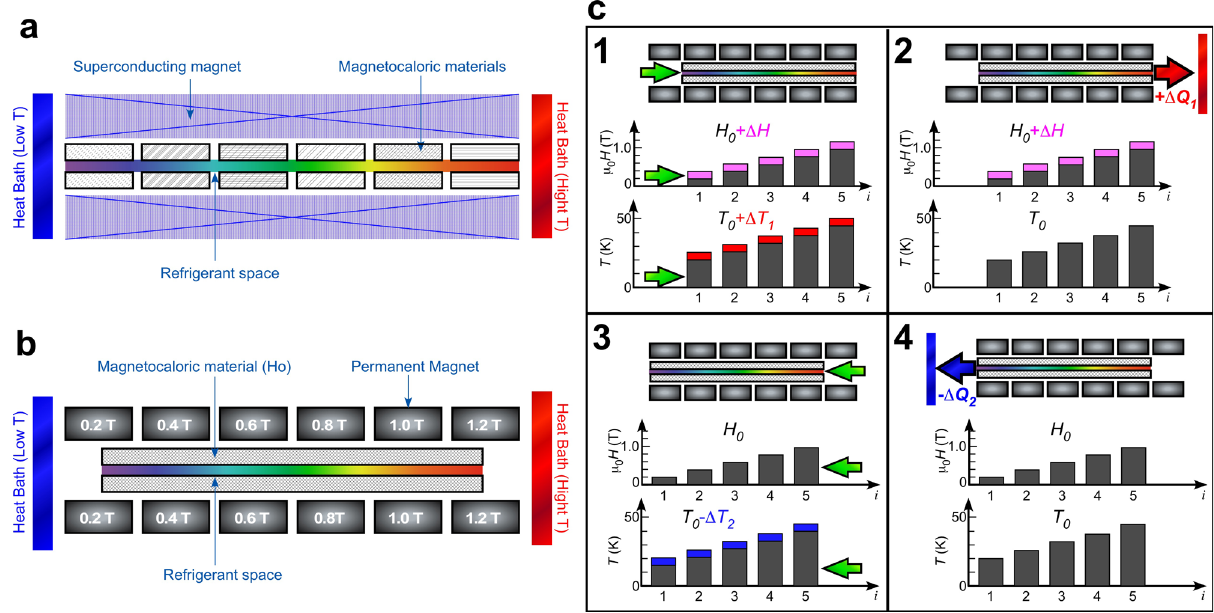
Fig. 6 Schematic illustration of active magnetic regenerator (AMR) using permanent magnets and holmium. a A cross-section of AMR setup 2,24 . The AMR constitutes a superconducting magnet, magnetocaloric materials, refrigerant space, and heat baths (low- and high-temperature sides). The magnetocaloric materials have different phase transition temperatures to obtain a large magnetocaloric effect at each position. b Possible setup of the proposed magnetic refrigeration (MR) system using a small change in magnetic fi eld. The system constitutes pairs of permanent magnets, magnetocaloric material (holmium), refrigerant space, and heat baths. The set of permanent magnets generate a magnetic fi eld gradient from 0.2 to 1.2 T as a bias magnetic fi eld μ 0 H 0 to change the magnetic phase transition temperature of the magnetocaloric material Ho. The magnetic fi eld change Δ μ 0 H is realized by mechanically moving the magnetocaloric material in the horizontal direction in this fi gure. c The MR cycle of the proposed AMR system. The gray color in the magnetic fi eld and temperature graphs denotes the bias fi eld μ 0 H 0 and the original temperature T 0 , respectively. The colored areas in the graphs are the changes in the magnetic fi eld Δ μ 0 H and temperature Δ T